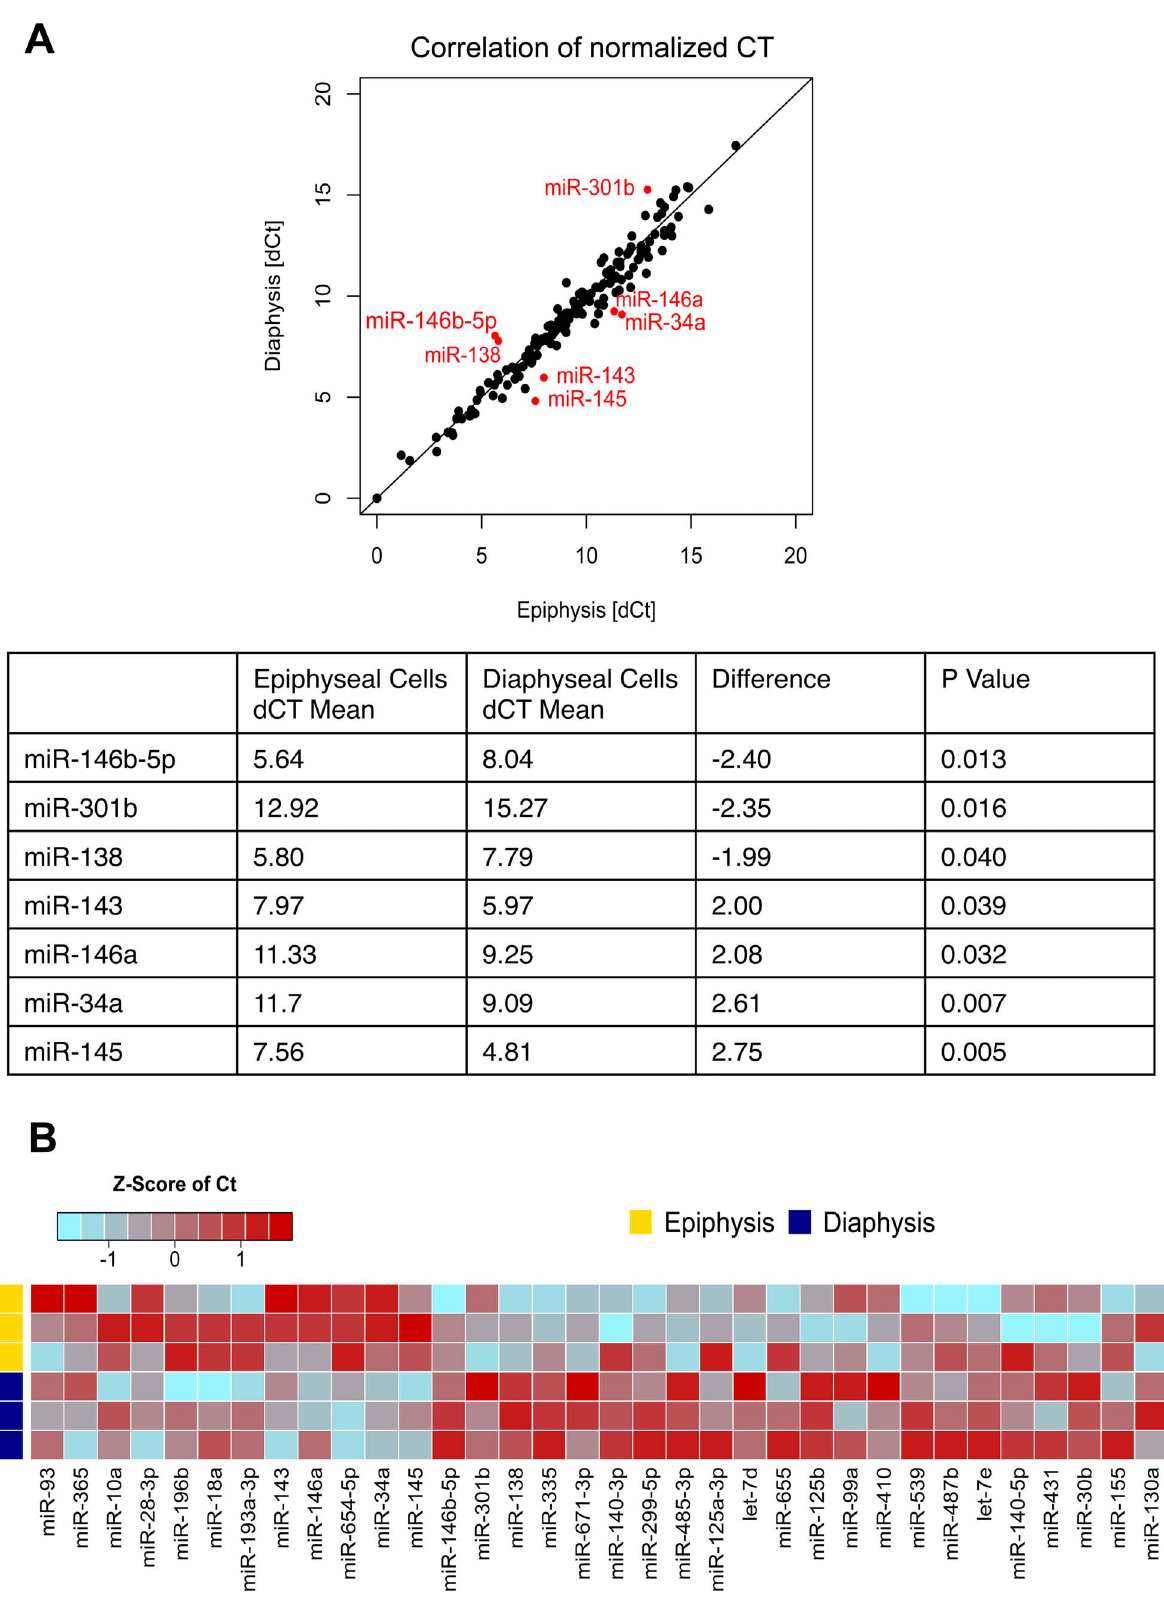
PLOS ONE | www.plosone.org